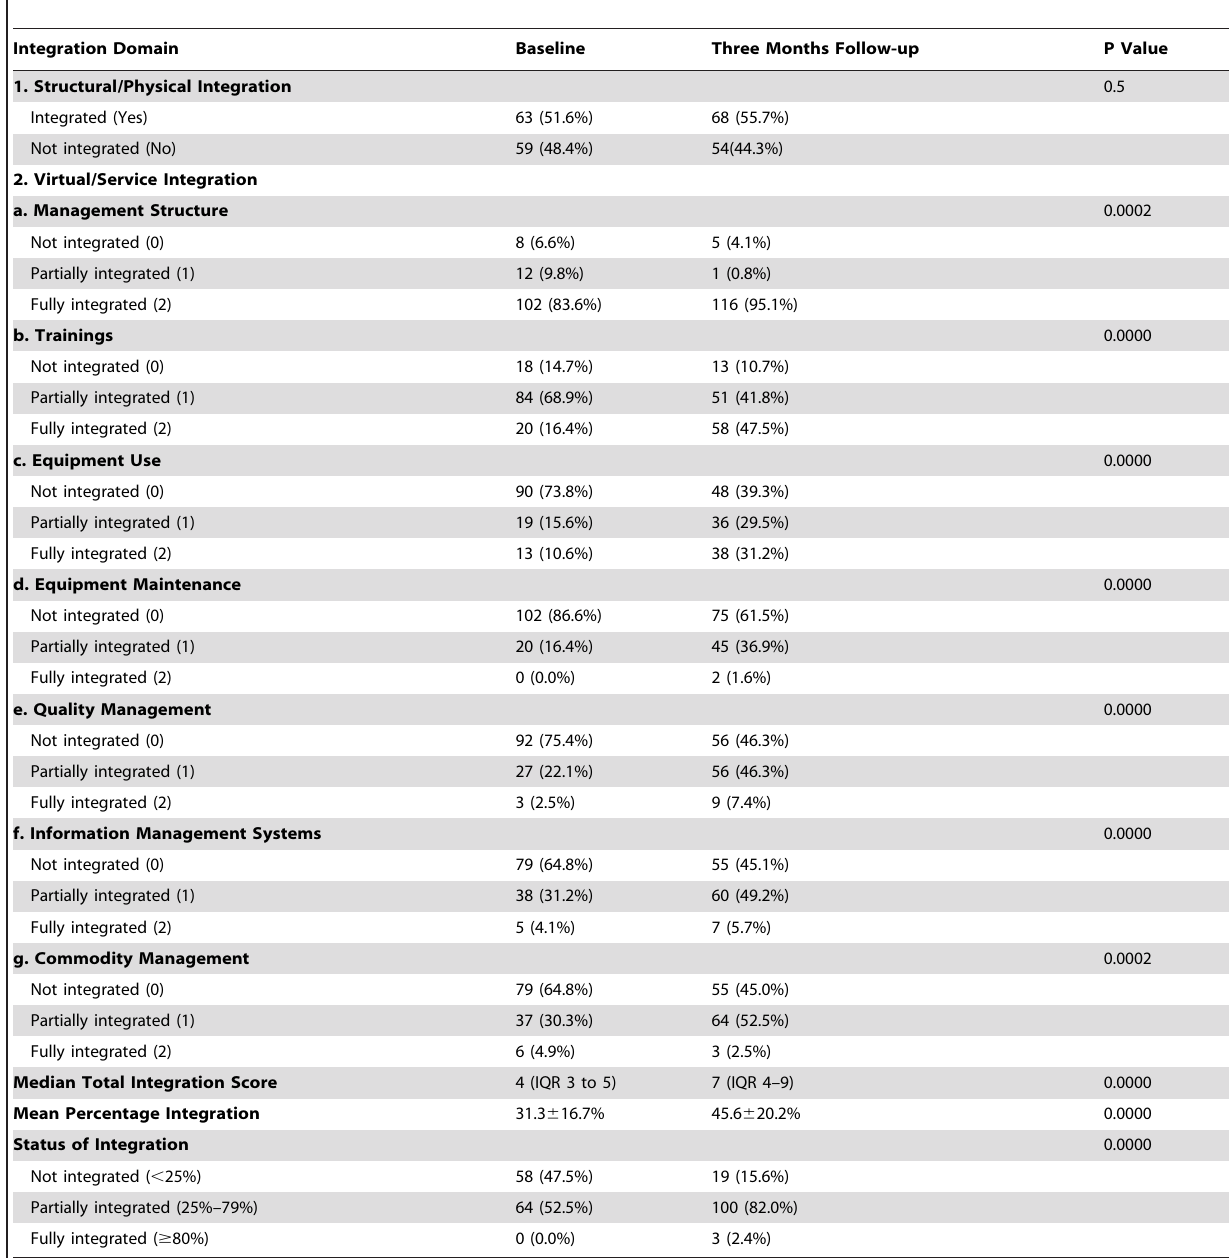
Table 2. Comparison of levels of laboratory service integration across domains at baseline and three months follow up.